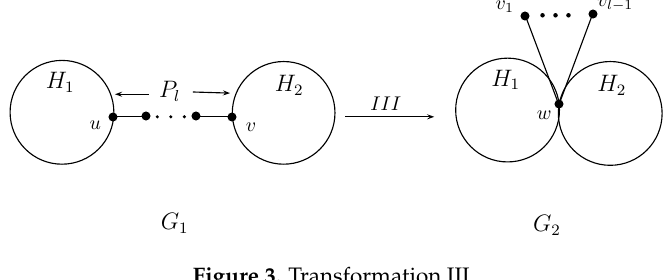
Figure 3. Transformation III.